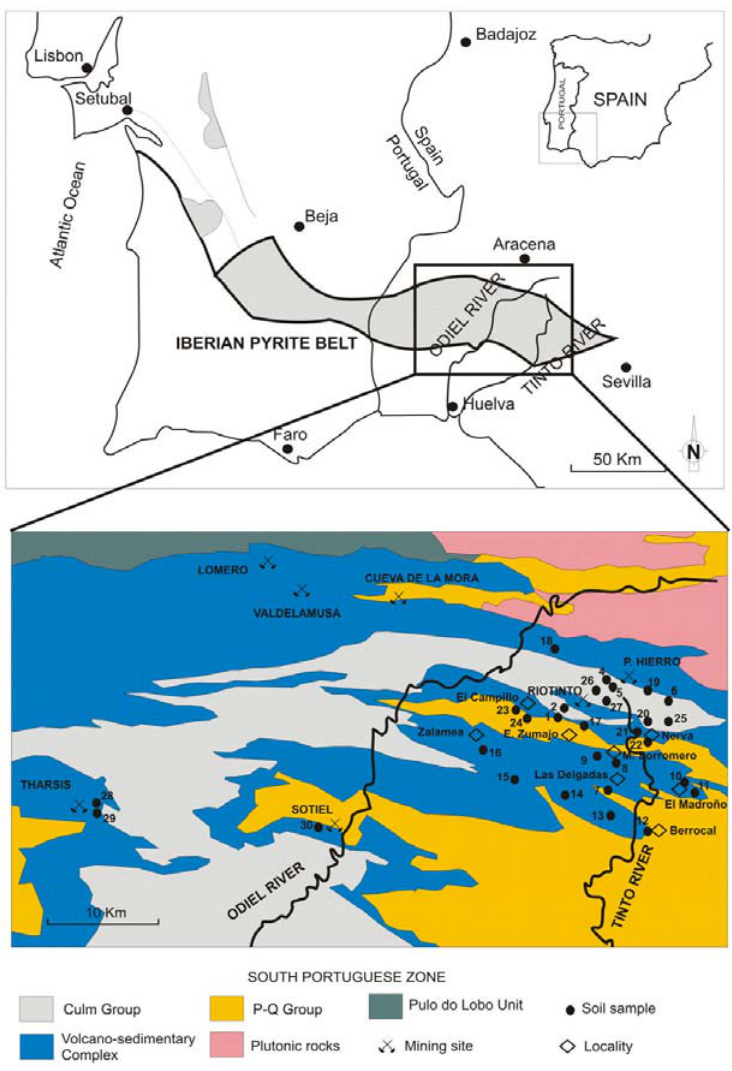
Figure 1. Sample location and geological setting of the Riotinto mining